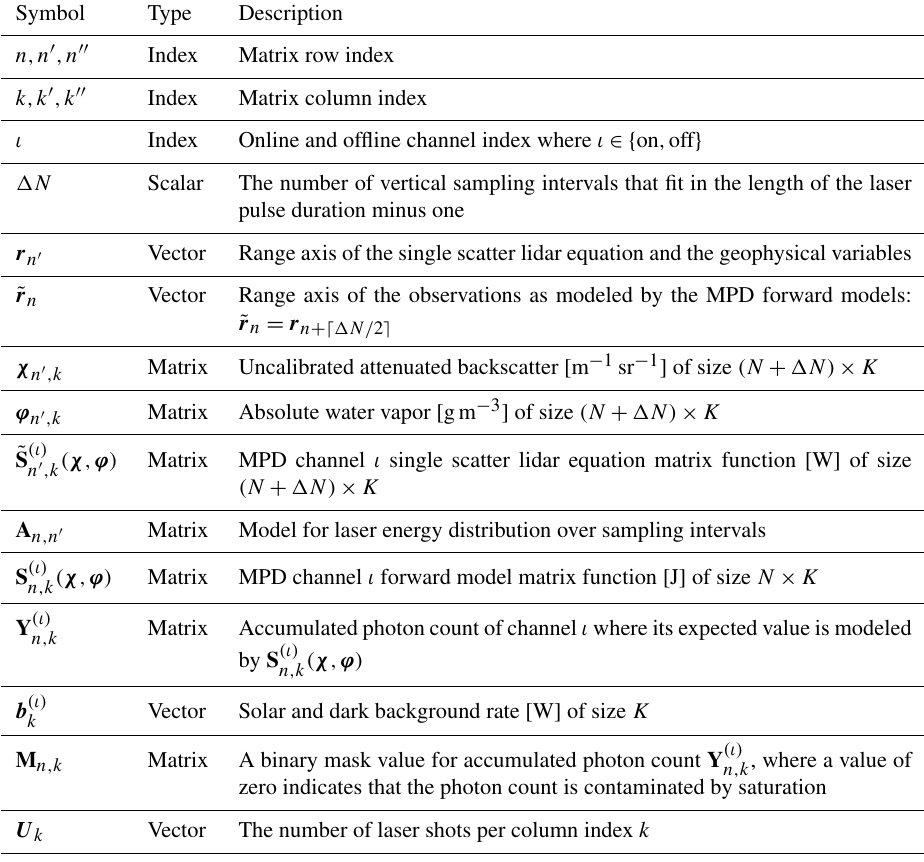
Table 1. Commonly used symbols. Symbol